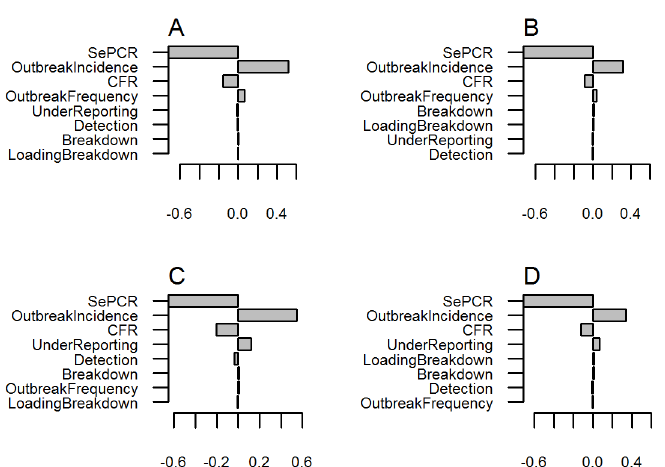
Fig 5. Tornado plots of correlation coefficients for input variables and probability of exporting an undetected infected horse. A, low-risk area with no post-arrival quarantine; B, low-risk area with post-arrival quarantine and PCR; C, endemic area with no post-arrival quarantine; D, endemic area with post-arrival quarantine and PCR.